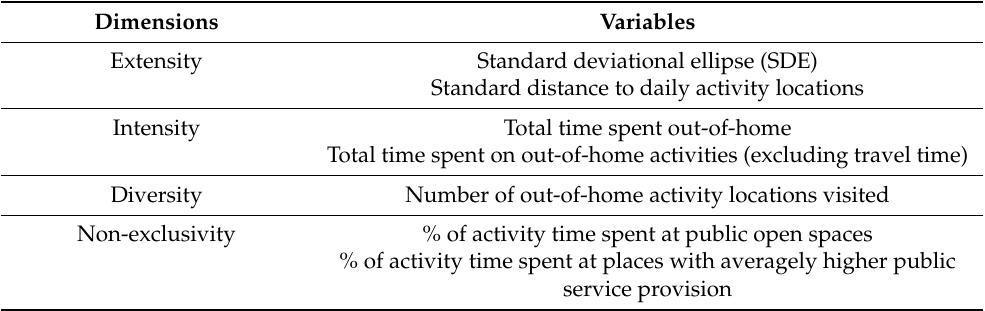
Table 1. Variables measuring the four characteristics of activity space.